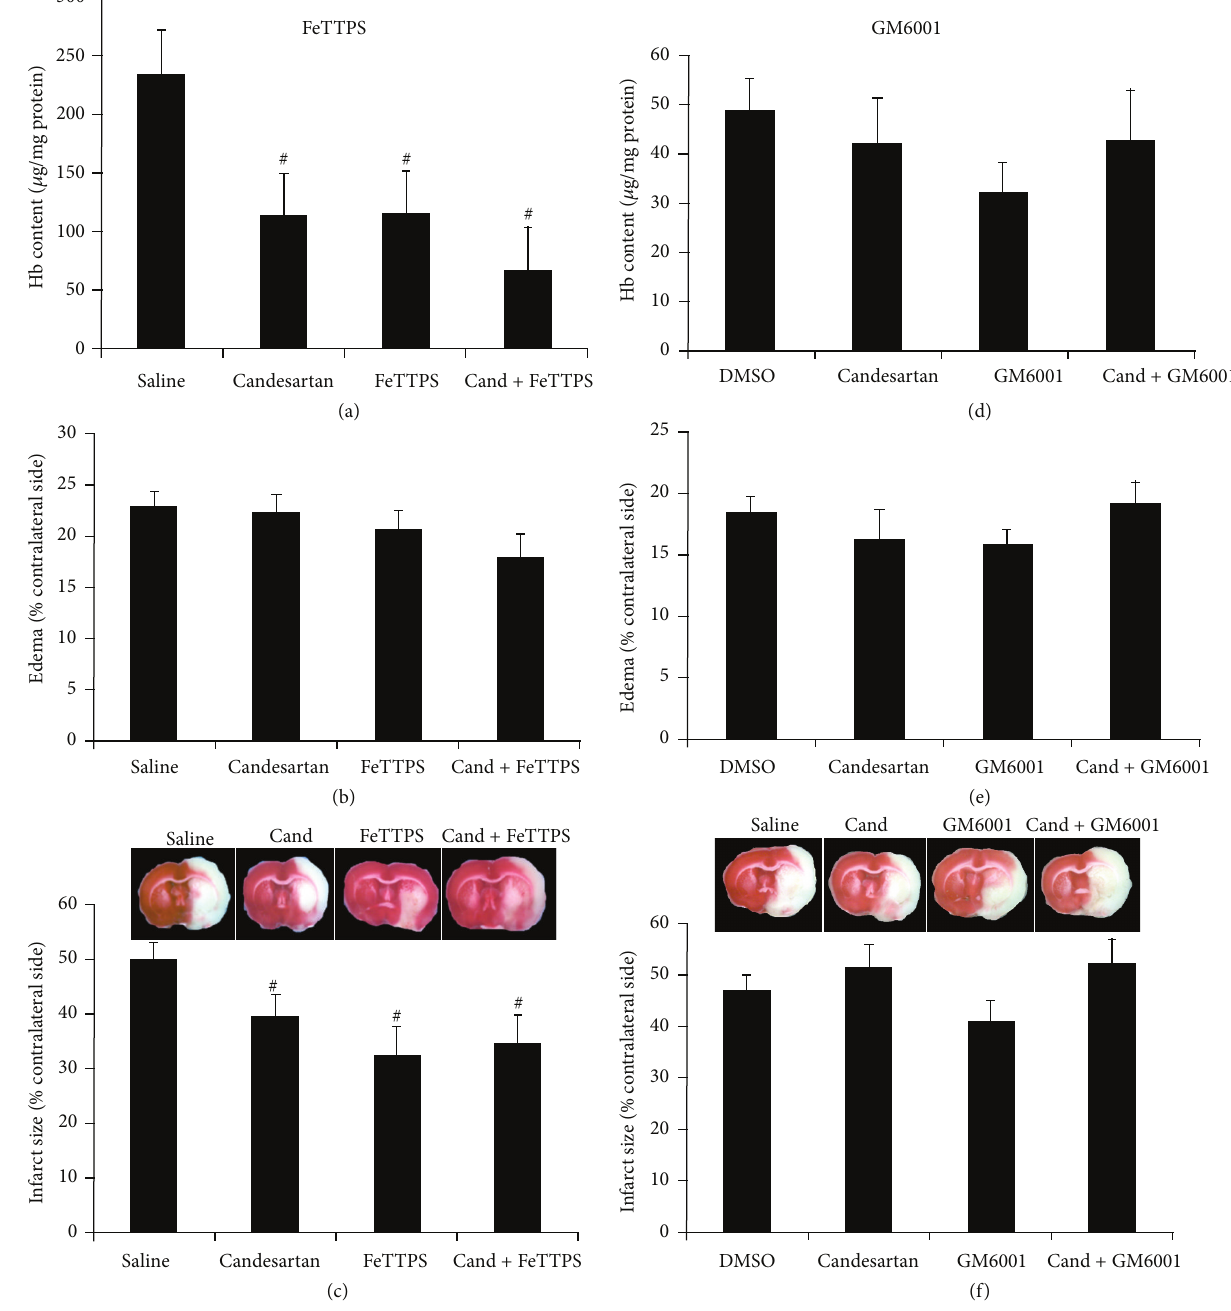
Figure 3: Effects of candesartan alone and in combination with FeTPPS and GM6001 on infarct size (a, d), edema (b, e), and hemoglobin content (c, f) at 24 h after MCAO. Infarct size and Hb content were significantly reduced in all three treatment groups in FeTTPS compared to the saline treated group ( # 𝑃 < 0.05 ). Candesartan alone and in combination with GM6001 did not reduce these outcomes when administered with DMSO, but GM6001 alone resulted in a significantly reduced infarct size. Values are mean ± SEM ( # 𝑃 < 0.05